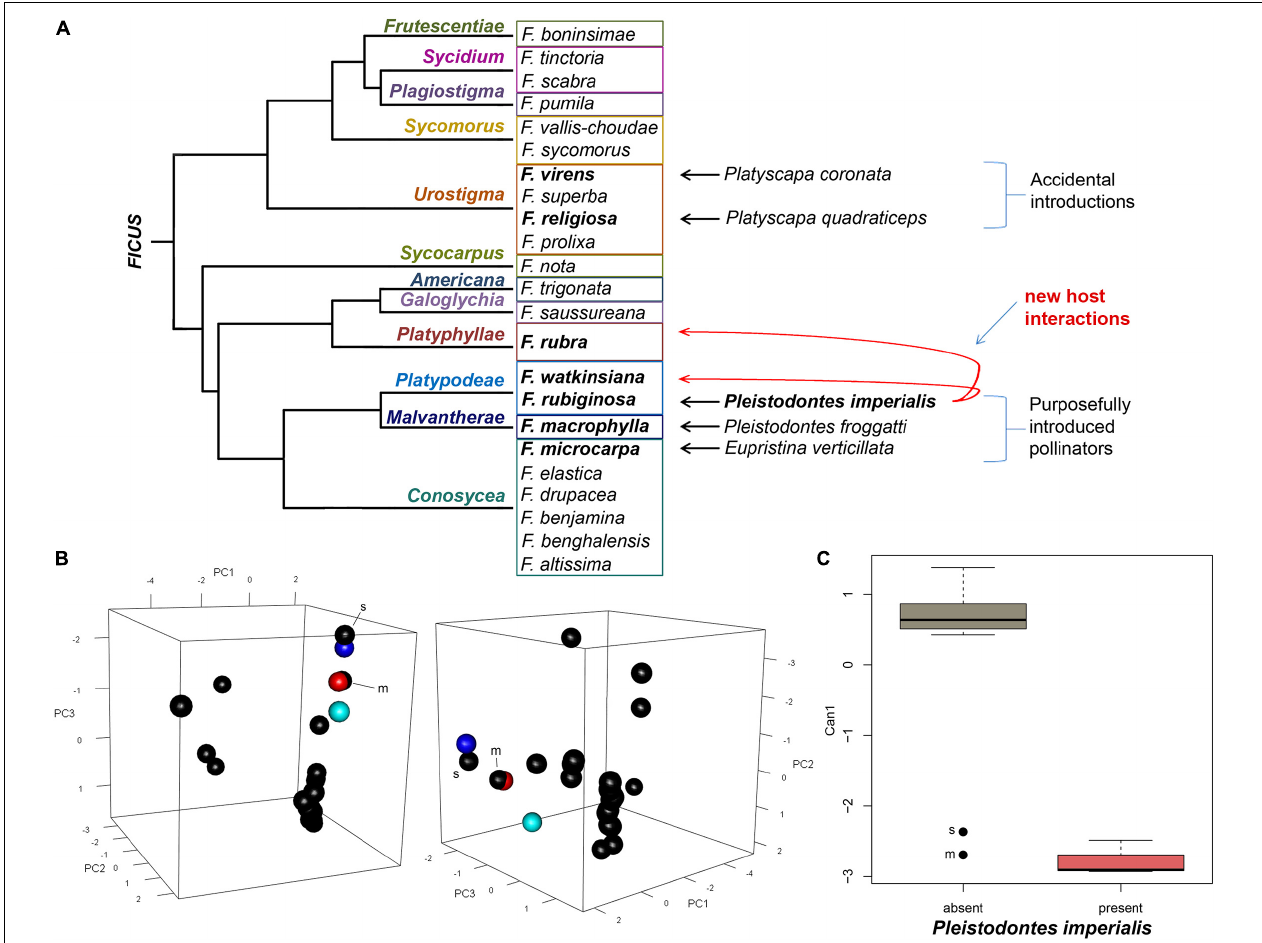
FIGURE 2 | (A) Cladogram representing subsections of fig species in this study [based on Xu et al. (2011)], showing host breadth expansions of Pleistodontes imperialis ; (B) principal component analysis of morphological traits of syconia shown from two angles, wherein black points are fig species without P. imperialis and colored points signify those with P. imperialis : cobalt blue = F. rubiginosa , red = F. rubra , aquamarine = F. watkinsiana ; black outliers are labeled: m = F. macrophylla , s = F. saussureana ; (C) canonical discriminant analysis showing variation between morphology of fig species with and without P. imperialis , where the axis represents 100% of